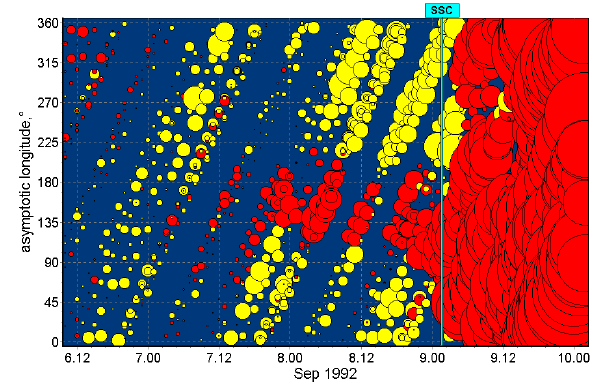
Fig. 4. Fig. 4. Galactic CR intensity pre-increase (yellow circles), and pre- decrease and Forbush - decrease (red circles) before and after the Sudden Storm Commencement (SSC) of the great magnetic storm on 9 September 1992. The bigger diameter of circle means a bigger amplitude of CR intensity